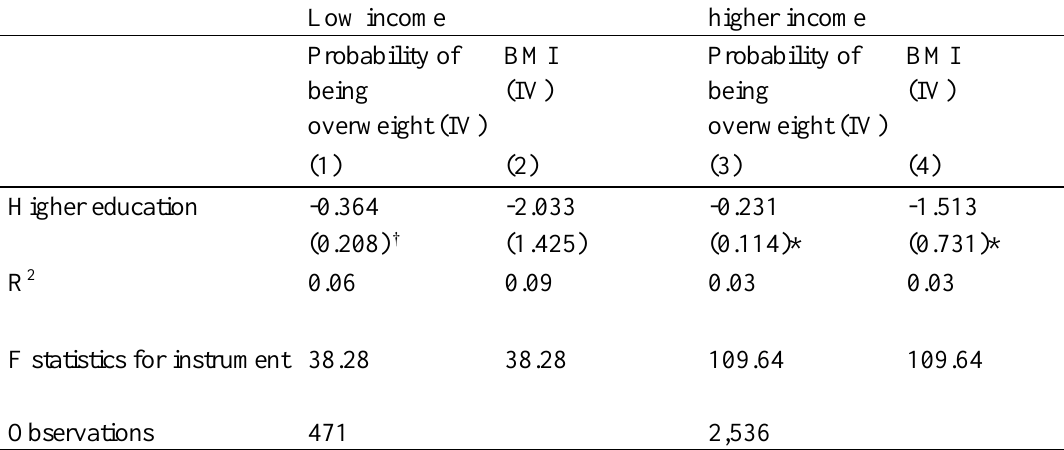
IV estimates for the effect on body weight of having a higher education among men by parental income background.